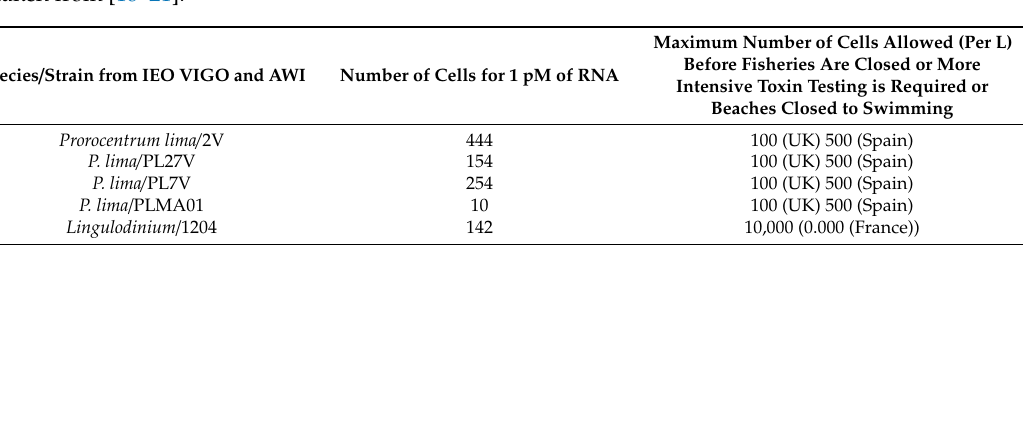
Table 3. Estimation of the number of cells equivalent to 1 pM of RNA as compared to the number required to trigger a warning. Alerts are usually about 1 / 3 of the level as a warning. Trigger levels were taken from